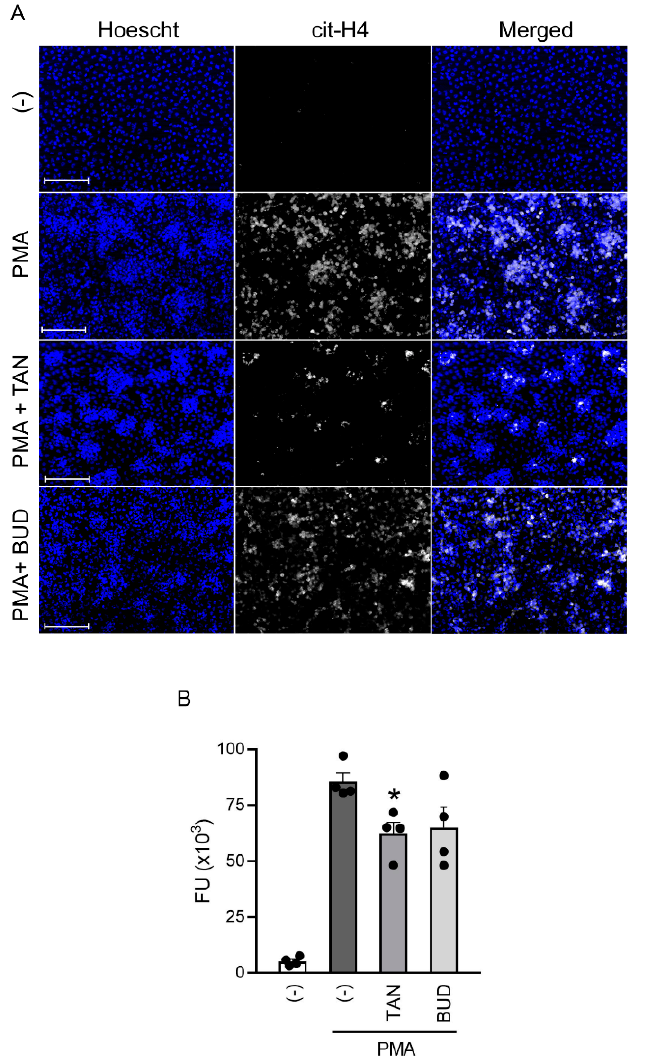
Figure 4. Tanimilast reduces NET production. Isolated neutrophils were left untreated ( − ) or exposed to PMA (100 ng/mL) in the presence of tanimilast (TAN) at 10 − 7 M, or budesonide (BUD) at 10 − 7 M. ( A ) NETs are identified by the association of citrullinated histon-4 (white) to DNA (blue). Scale bar: 100 μ m. ( B ) Casted NETs were quantified in cell supernatants by analysing DNA-associ- ated elastase activity after a limited DNase I digestion. Results are expressed as fluorimetric readout (FU, Fluorimetic Unit) of elastase activity in the cell supernatants. Dots represent the result of indi- vidual donors ( n = 4). * p < 0.05% One-way ANOVA followed by post-hoc test.